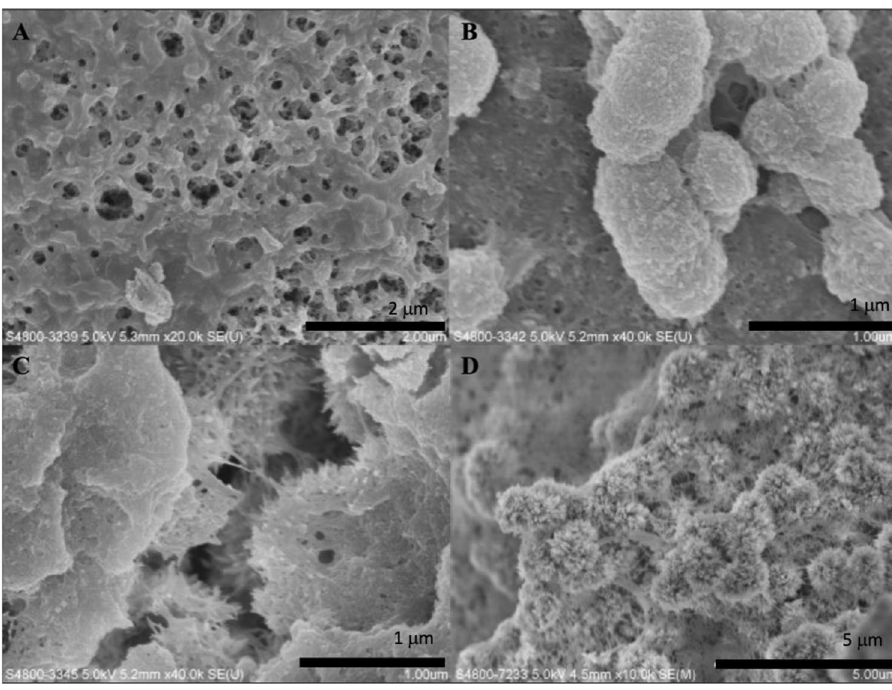
Figure 2. SEM micrographs of synthesized biomaterials treated with a current of 10 mA, after different mineralization time. ( A ) 3 h; ( B ) 4 h; ( C ) 6 h; ( D ) 8 h.